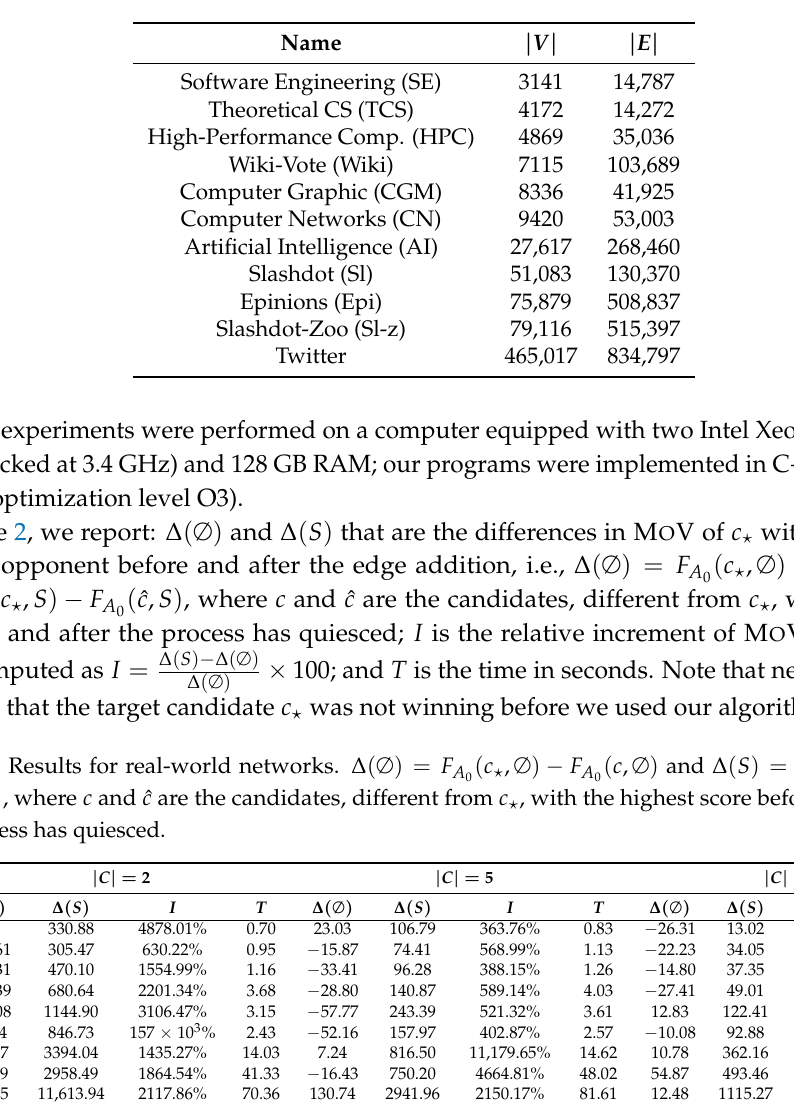
Topk (TopK) selects the nodes with the highest harmonic centrality [33]; and Prob (Prob) selects nodes adding the edges with the highest probability. Note that some of these algorithms are well-known algorithms used for link recommendation. For each graph, we report in Tables 3 and 4 the relative increment of M O V, defined above as I . The experiments clearly show that our proposed algorithm outperforms all the alternative baselines with respect to the final value of M O